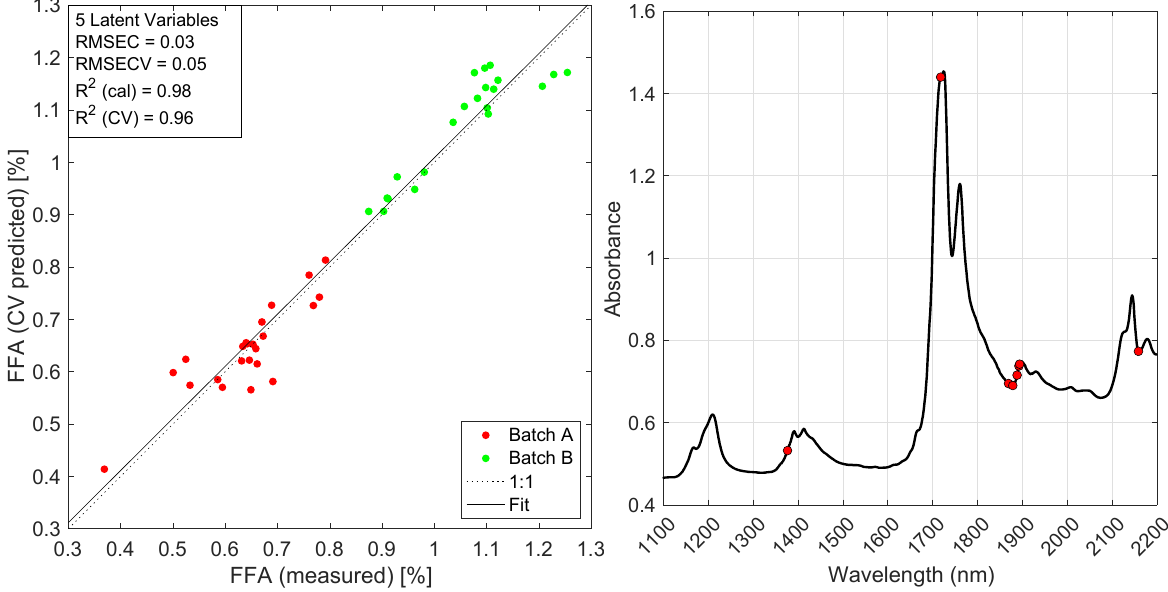
Figure 8. Left: Measured vs. predicted plot of optimal rPLS model (30 s averaging, SG15,2,2, 5 LVs; see Figure 7). Right: Average spectrum with the eight wavelengths chosen by the rPLS algorithm as indicated in red (1377, 1718, 1869, 1879, 1888, 1892, 1894 and 2159 nm).